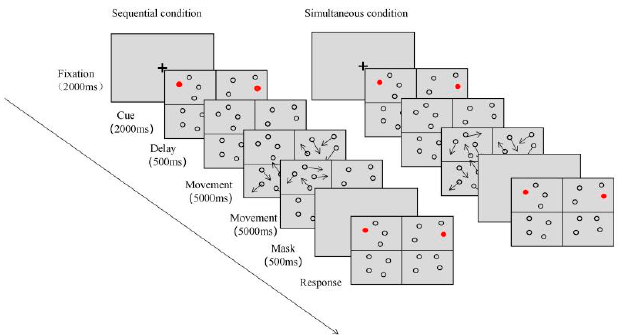
Figure 3. A Combination of MOT task and simultaneous–sequential paradigm.